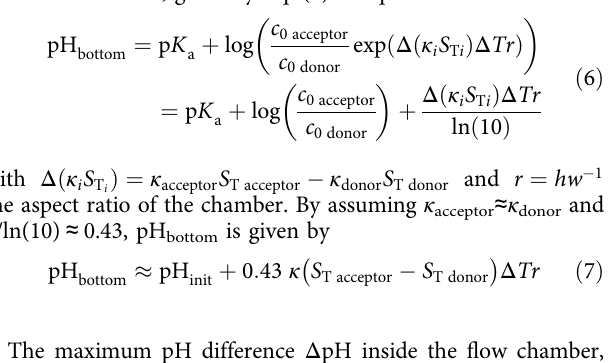
The maximum pH difference Δ pH inside the fl ow chamber, arising between the lowest and highest regions of the chamber, is given by Δ pH (cid:3) 0 : 86 κ Δ S ð Þ Δ Tr ð 8 Þ T with Δ S T = S Tacceptor − S Tdonor . The steepness of the pH gradient is affected by the temperature difference Δ T , Soret coef fi cient S T ,